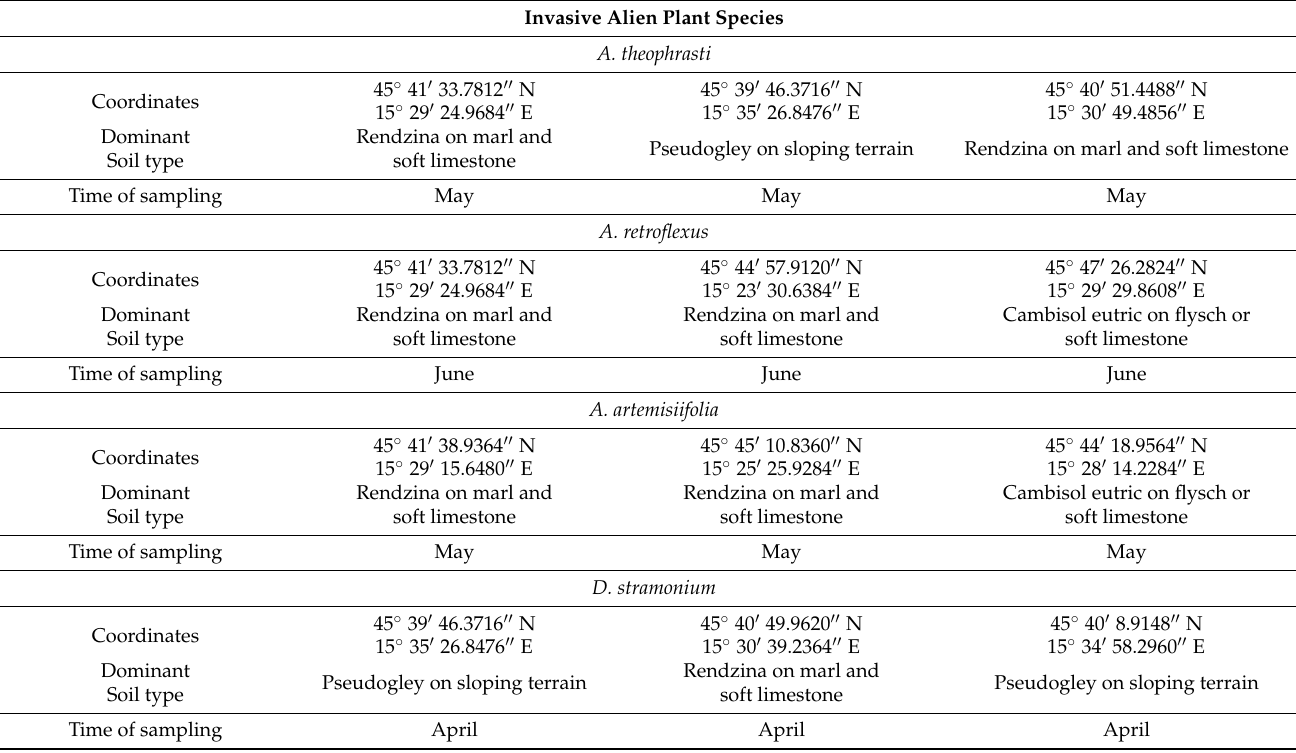
Table 5. Geographical coordinates, meteorological data [62], and soil type [63] of collected IAS on the Žumberak area. Invasive Alien Plant Species A.